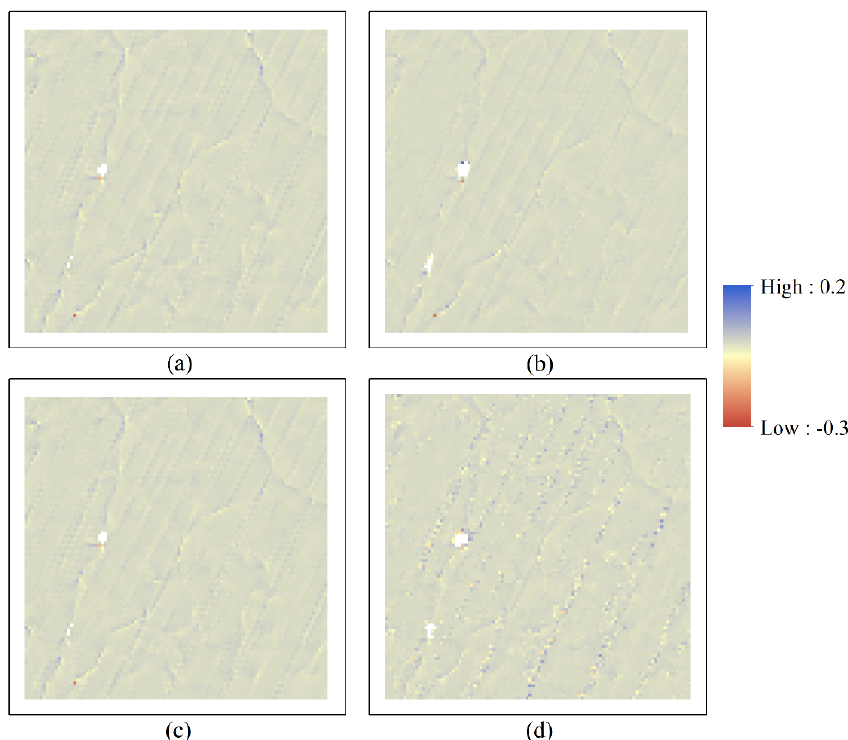
Figure 16. Spatial distribution of the simulated C values of the subregion for the: ( a ) Evans, ( b ) Zevenbergen, ( c ) Shary, and ( d ) FPN-based methods.